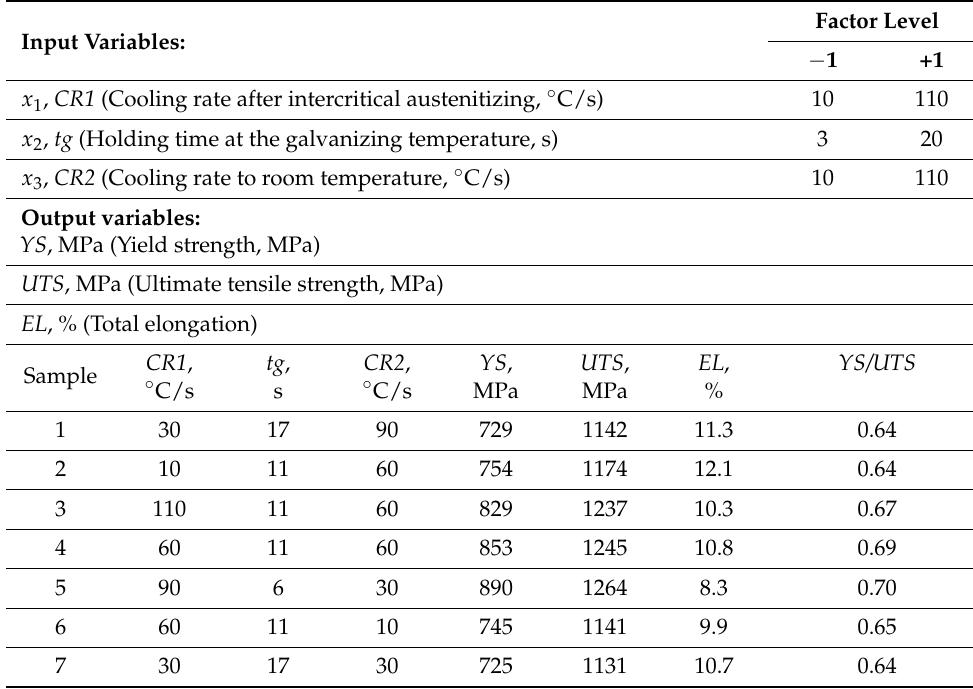
Figure 1. Graphic representation of the thermal cycles experimentally simulated by quenching dilatometry. The heat treatment variables studied ( CR1 , tg and CR2 ) and corresponding range are highlighted in the cooling profile, taken from [26]. Table 2. Resulting experimental matrix used in this research work